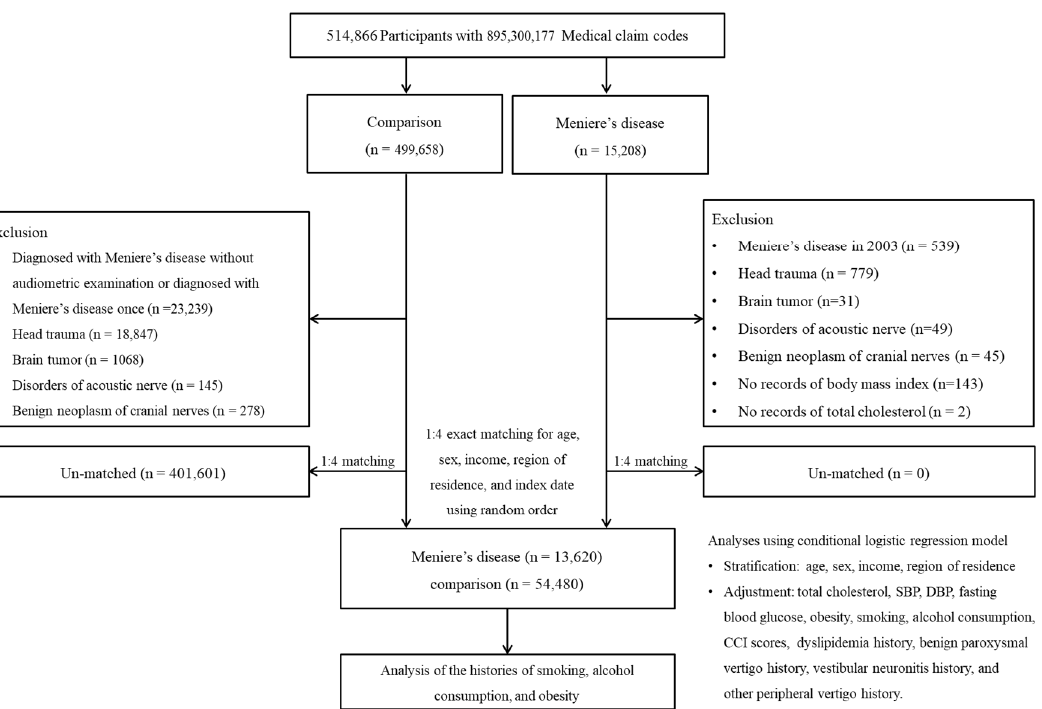
Figure 1. A schematic illustration of the participant selection process used in the present study. Of a total of 514,866 participants, 13,620 MD participants were 1:4 matched with 54,480 comparison participants for age, sex, income, and region of residence. (SBP: systolic blood pressure; DBP: diastolic blood pressure)